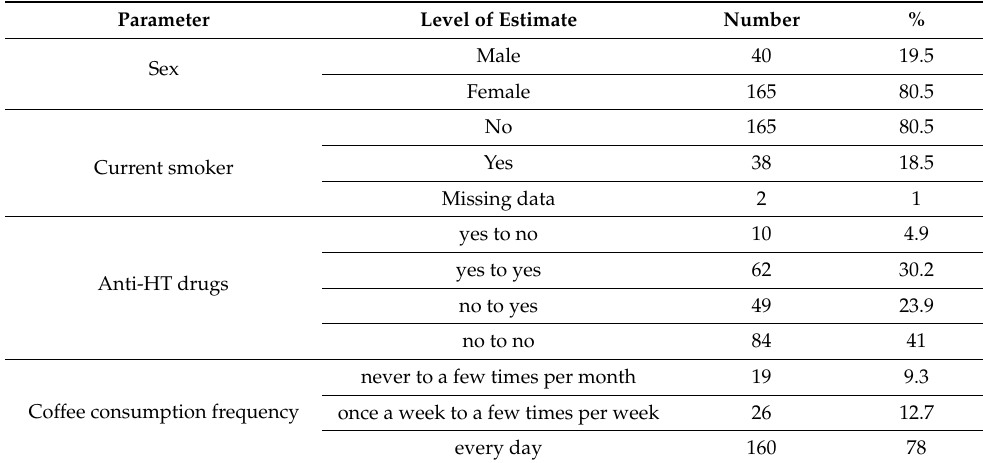
Table 2. Qualitative variables included in linear mixed